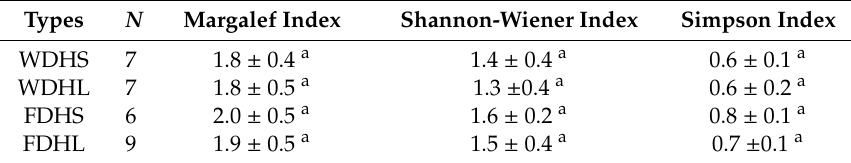
Table 10. Ecological values of di ff erent home garden types and